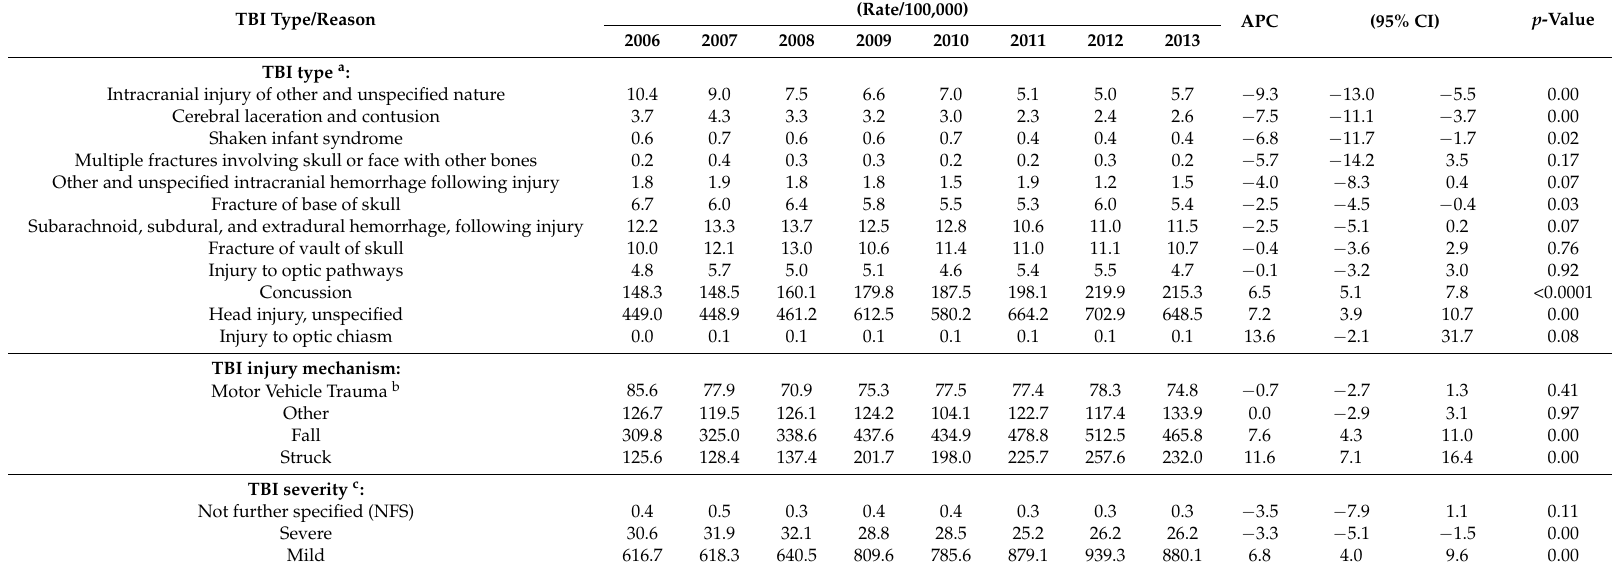
Table 3. Trend of age-adjusted rates of TBI-related ED visits by TBI type, injury mechanism, and severity in the U.S., 2006–2013,